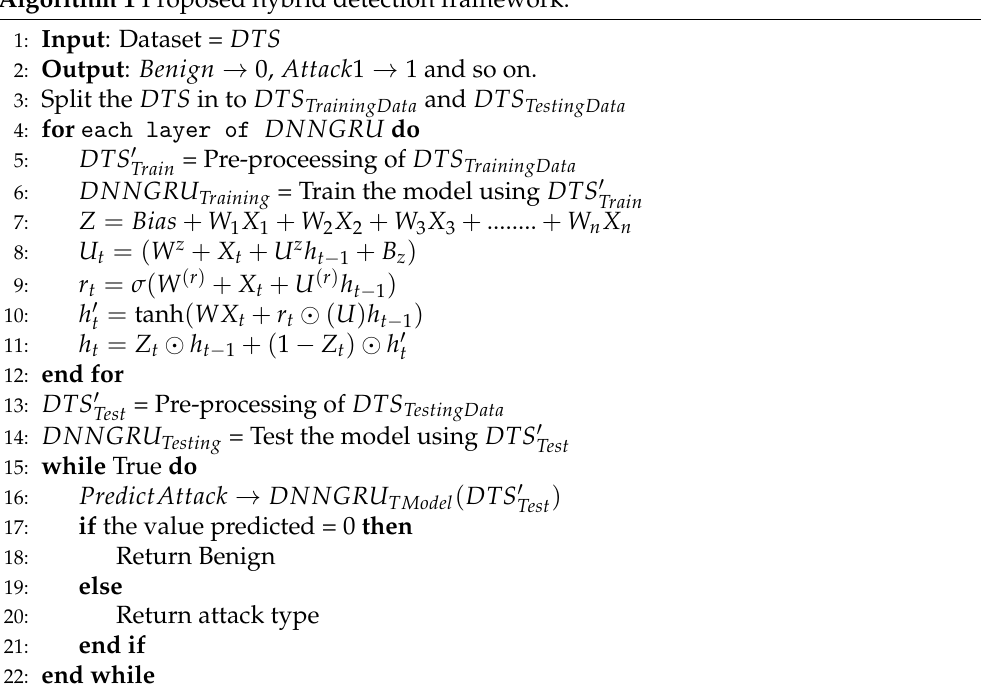
Algorithm 1 Proposed hybrid detection